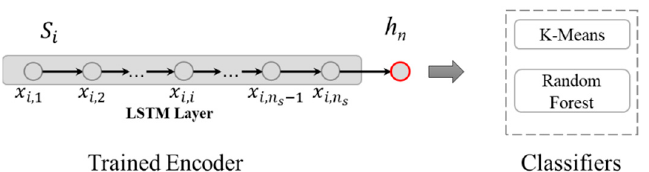
Figure 5. Classification diagram based on the trained encoder.